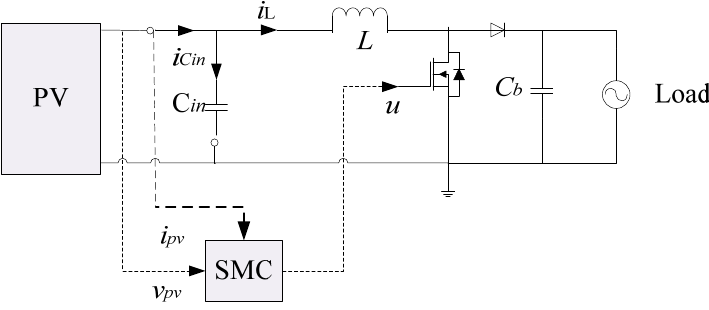
Figure 3. Circuital scheme of the sliding mode controller (SMC) loop.